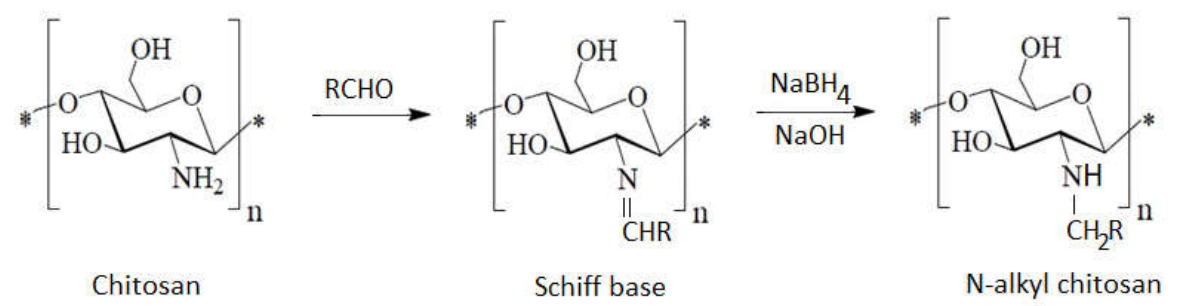
Figure 9. N-alkyl chitosan obtained via Schiff base, according to [97,99].